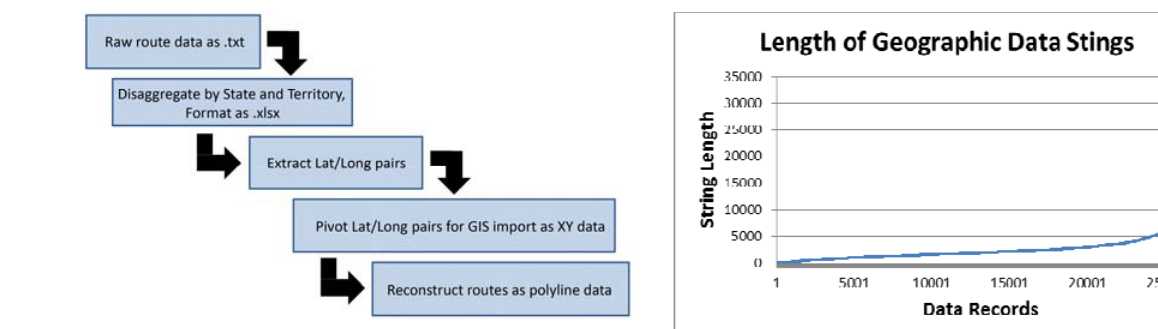
Figure 1. Data Processing Steps and Flow